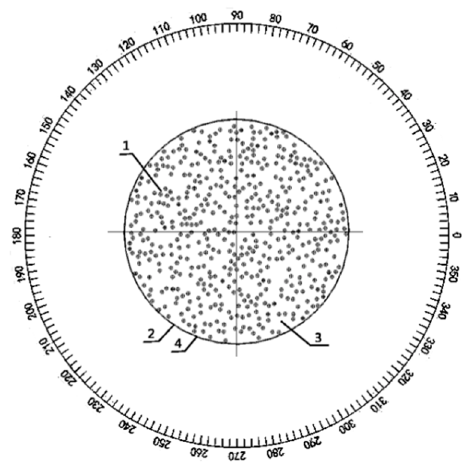
Figure 9. 360 di ff erent detection positions of magnetic nanoparticle Figure 9. 360 different detection positions of magnetic nanoparticle device.